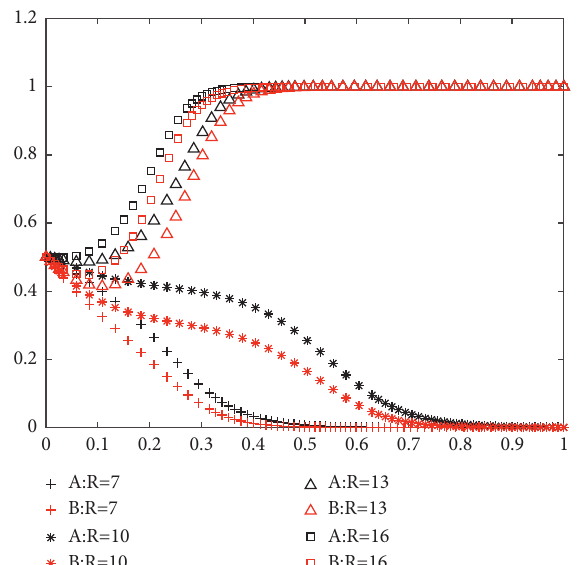
Figure 6: Evolutionary analysis of the changes in the cooperative income of SMEs with the participation of fintech